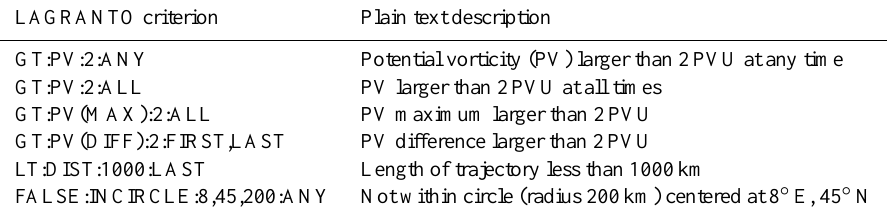
Table 2. Examples of selection criteria. A typical call of the LAGRANTO select program takes the following form: select inp.trajectory out.trajectory criterion , where the first two arguments provide the input and output trajectory files and the third one defines the selection criterion, as exemplarily given in the left column. For a complete list of all options with examples, consider the reference guide at www.